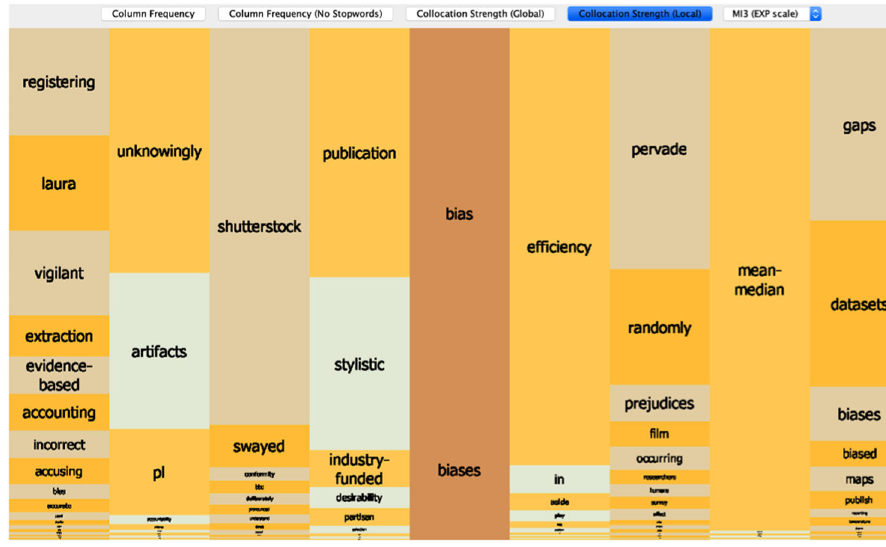
Fig. 3 Mosaic visualization of bias/-es in CSBC-ACC (38 lines). Collocation strength: Local, MI3 (EXP